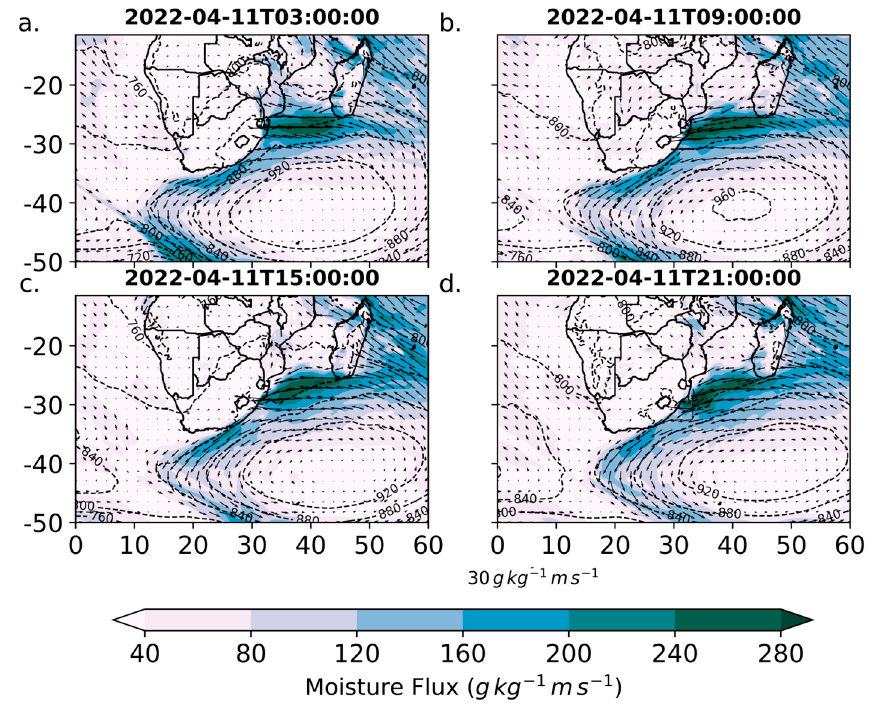
Figure 3. Same as Figure 2, but for the 925 hPa level at ( a ) 0300 UTC ( b ) 0900 UTC ( c ) 1500 UTC and ( d ) 2100 UTC on 11 April 2022. Here, only regions with moisture flux values exceeding 40 g kg − 1 m s − 1 are shaded.